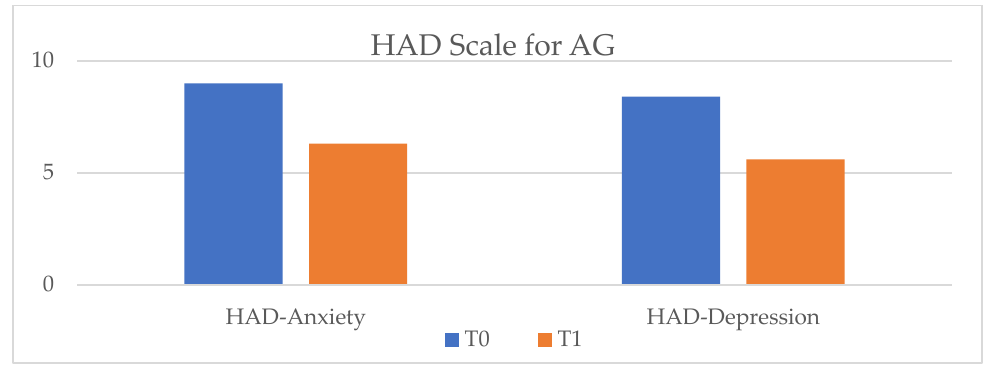
Figure 5. HAD scale results for AG at T 0 and T 1 . HAD = hospital anxiety and depression scale; AG = control group; T 0 = before the rehabilitation period; T 1 = after the rehabilitation period .